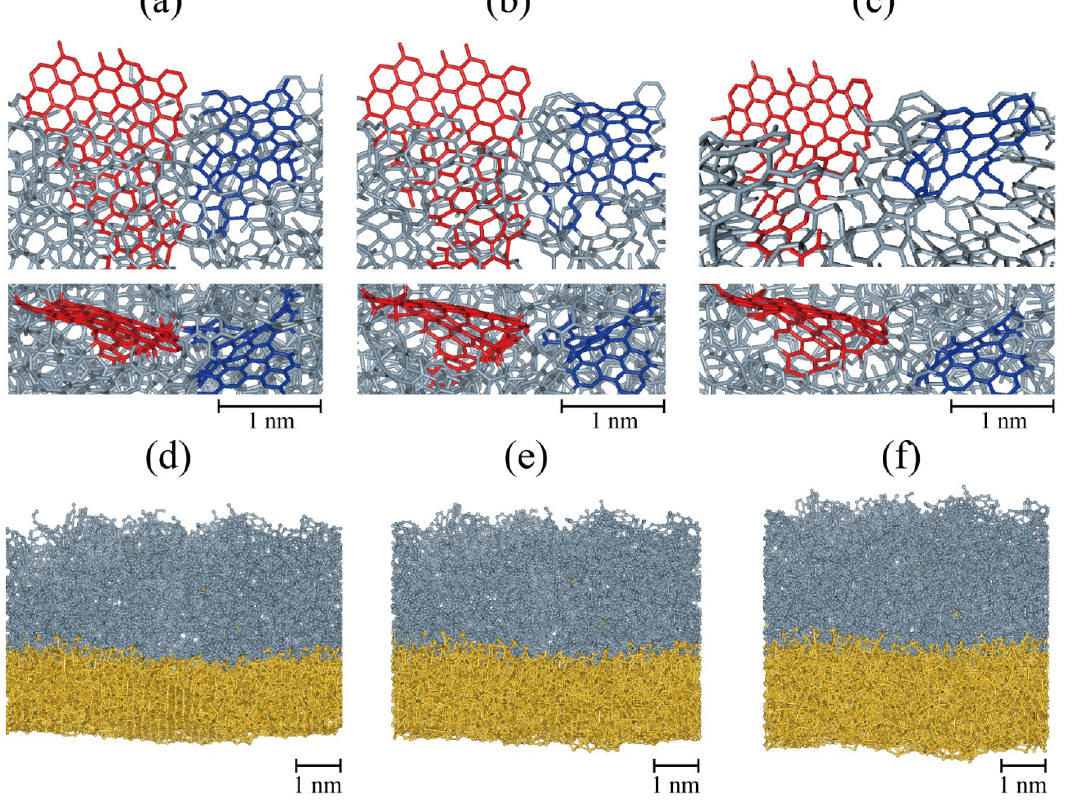
Figure 4. Structural evolution during expansion ( a – c ) and contraction simulations of the 1 eV-grown film. Biaxial strains are ( a ) 0%; ( b ) 12.5%; ( c ) 25%; ( d ) 35%; ( e ) 25%; and ( f ) 15%. The film is expanded from 0% to 50%, then returns to 0% strain. In ( a – c ), only a part of carbon film is shown to clearly display the structural evolution of BSUs colored in blue and red. In ( d – f ), the composite of carbon film (gray) and the silicon substrate (yellow) almost recover its original shape after a cycle of expansion and